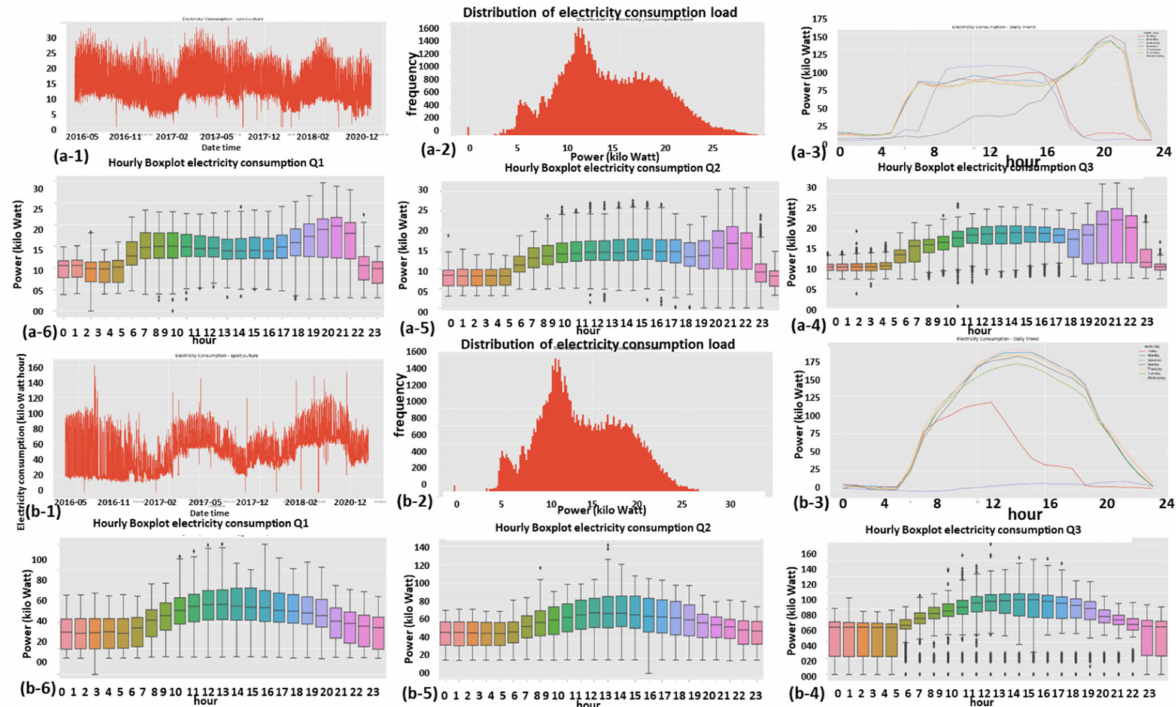
Figure 24. Two characteristics of non-fraud examples. Left to right: ( a-1 ) load profile, ( a-2 ) energy distribution, ( a-3 ) daily-hourly trends, ( a-4 ) Q3 seasonal-hourly boxplot, ( a-5 ) Q2 seasonal-hourly boxplot, ( a-6 ) Q1 seasonal-hourly boxplot. All graphs indicate normality. ( b-1 – b-6 ) same graphs for another meter.